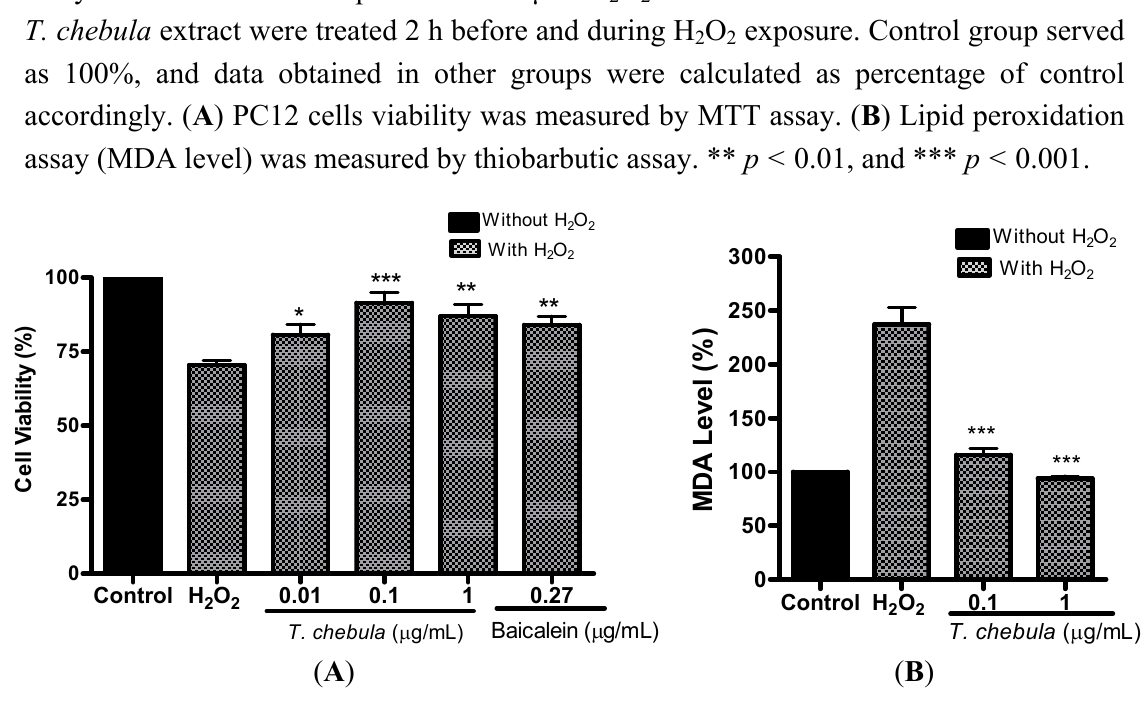
Figure 3. Effect of T. chebula extract on H